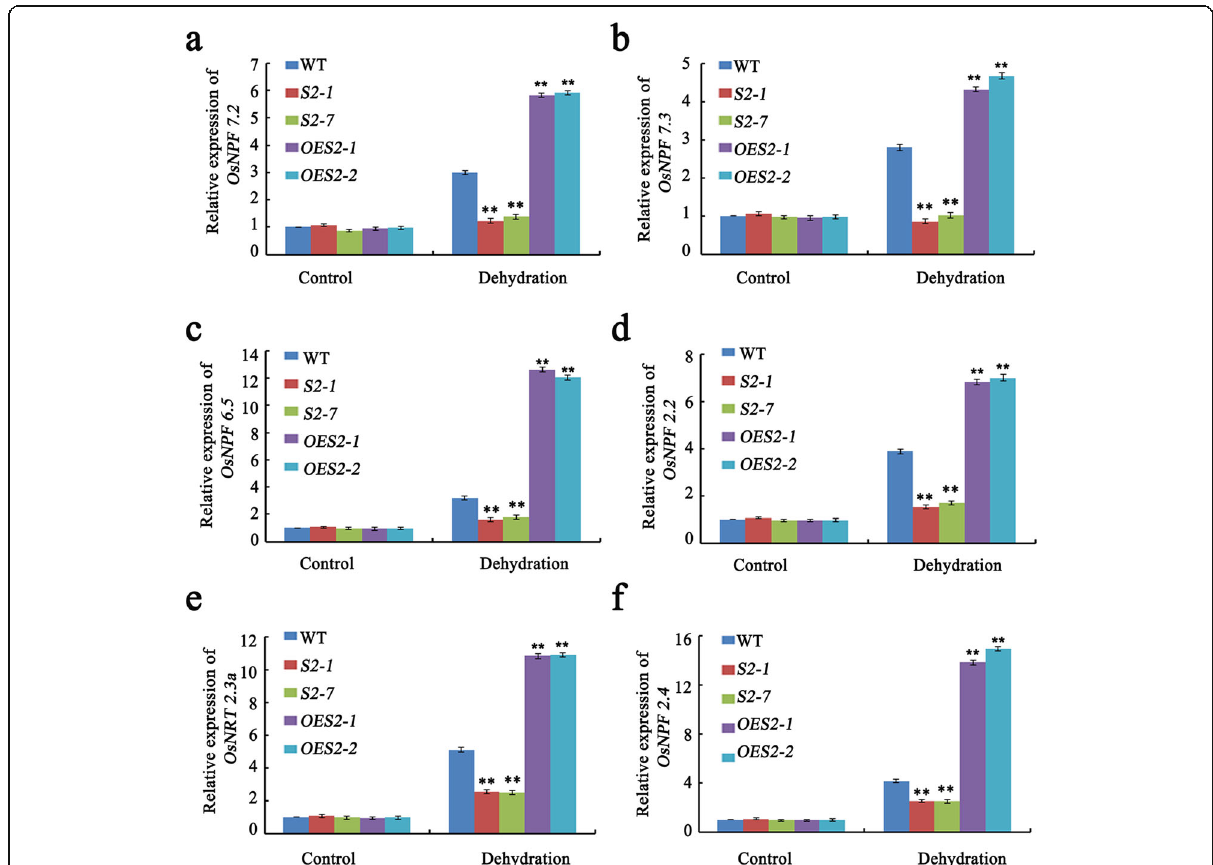
Fig. 6 Expression of genes involved in absorbing, transporting and assimilation of nitrate among WT, OE lines and sapk2 mutant lines. a-f Relative expression analysis of OsNPF7.2 ( a ), OsNPF7.3 ( b ) , OsNPF5.6 (c) , OsNPF2.2 ( d ), OsNRT2.3a ( e ) and OsNPF2.4 ( f ) among WT, sapk2 mutant lines and OE lines control conditions and drought stress conditions. Data are shown as means ± SD ( n = 20) from three replicates. A student ’ s t -test was used to generate P values; “ ** ” indicate significance at P <